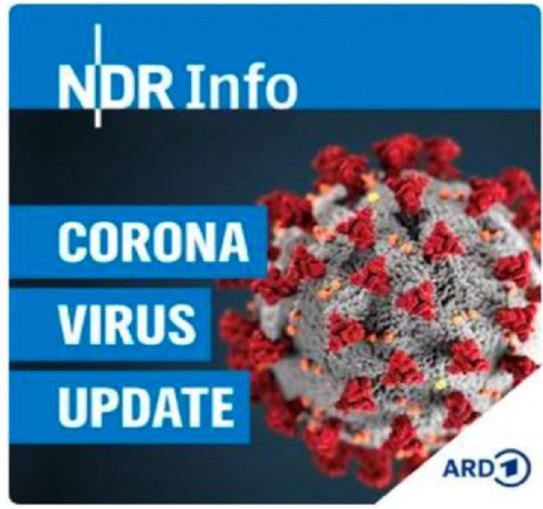
Fig. 6 The German-language Coronavirus update podcast was accessed over 142 million times, and 75% of listeners reached the end of each